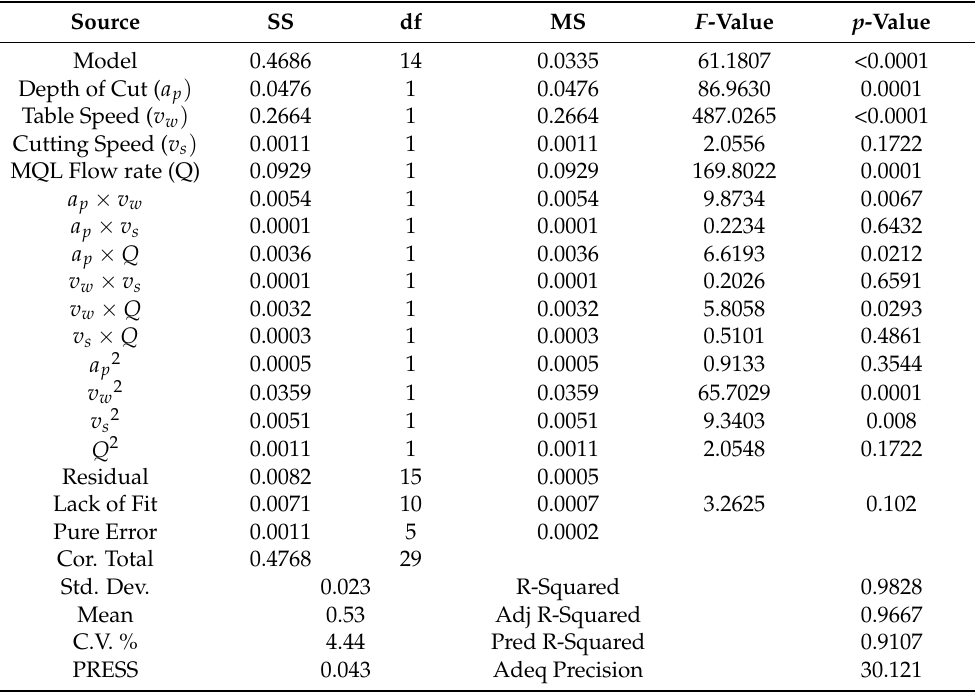
Table 6. ANOVA analysis for GRG of MQL